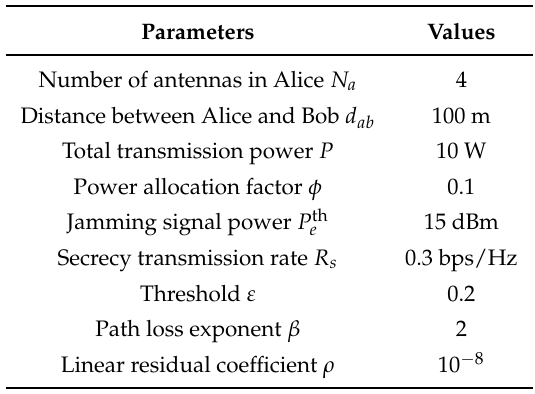
Table 1. Simulation